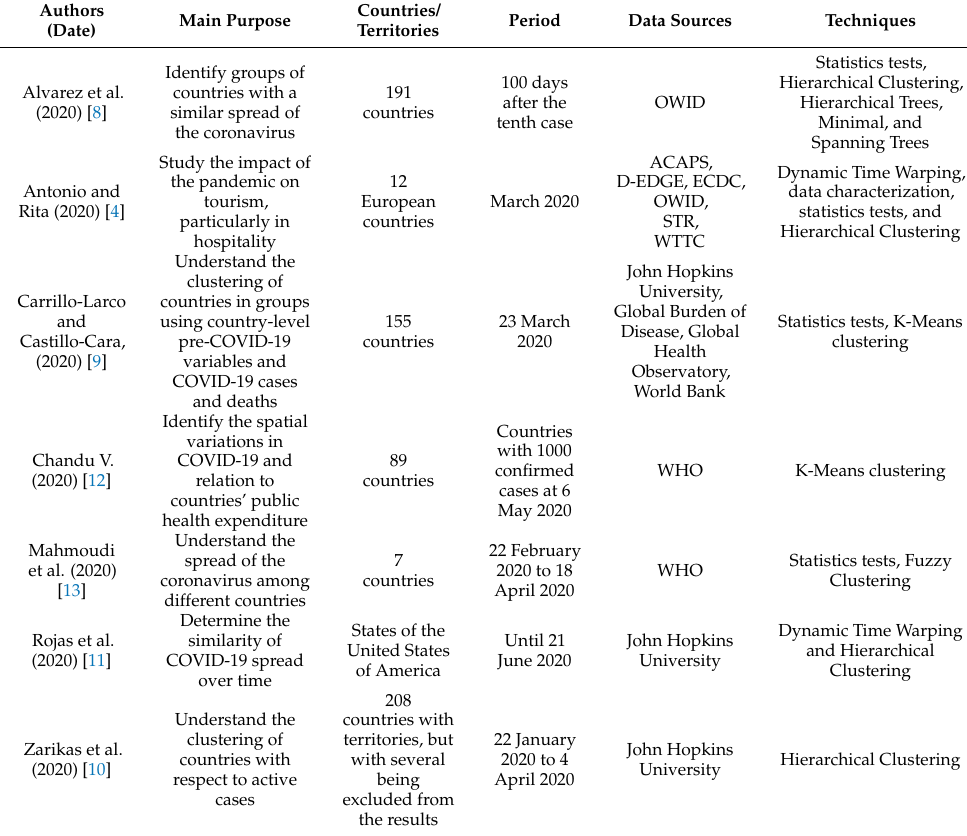
Table 1. Summary of Publications Related to the Temporal Analysis and Clustering of the Impact of COVID-19 by